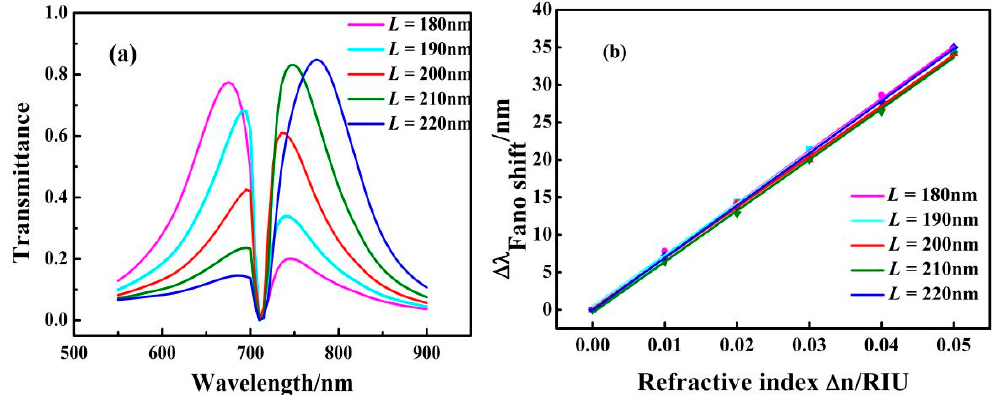
Figure 5. ( a ) Transmission spectra for different lengths L of the coupling cavity; ( b ) Fitting curves of Fano resonance peak shift caused by a change in the refractive index of Δ n with different values of L .